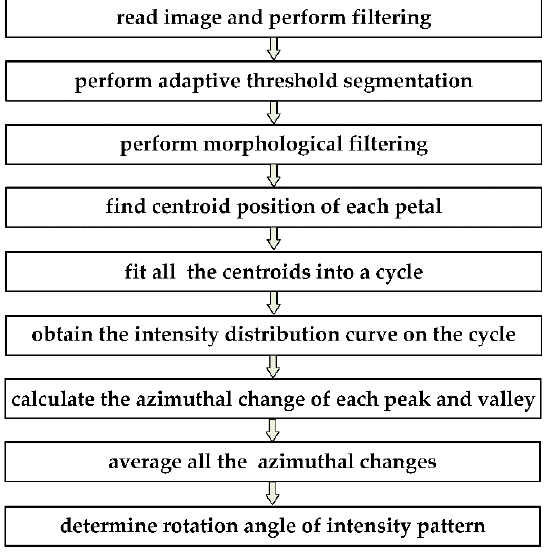
Figure 5. Flow chart of the image processing.